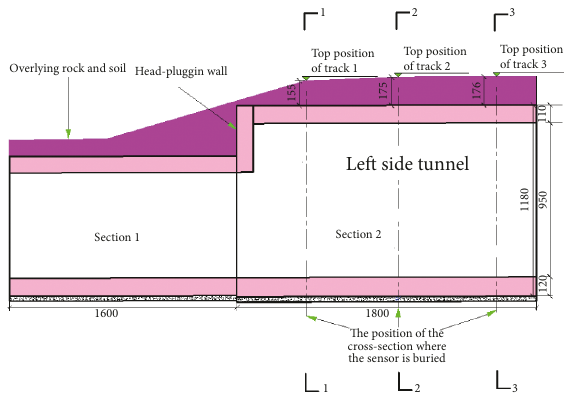
Figure 3: Schematic diagram of the cross section where the sensor is located (unit: cm).